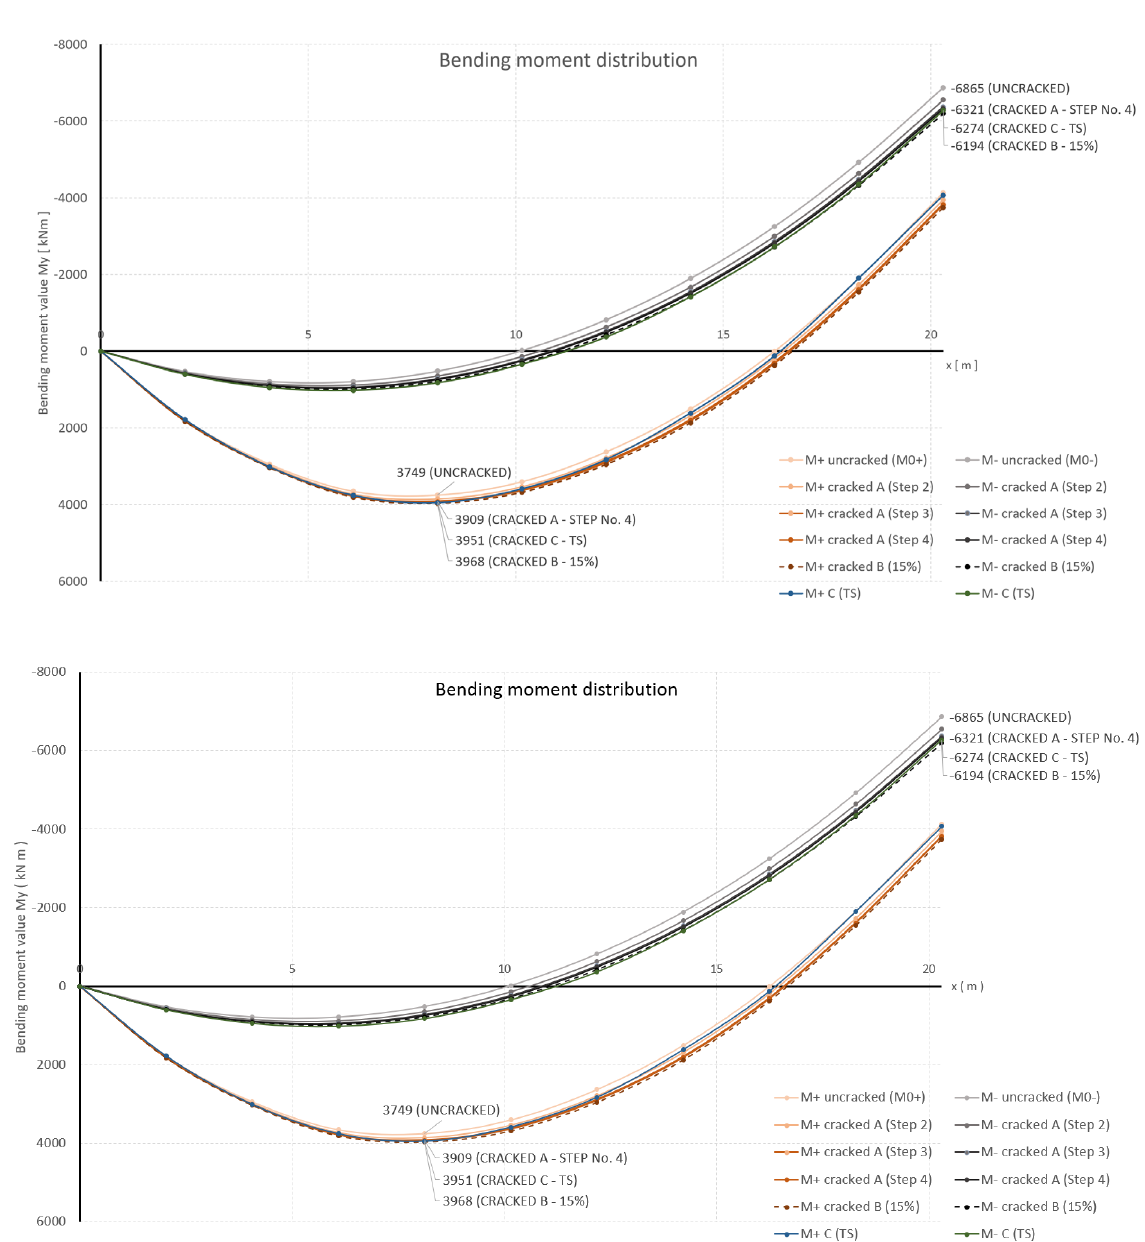
Figure 19: Bending moment envelope depending on the assumed approach (A, B,